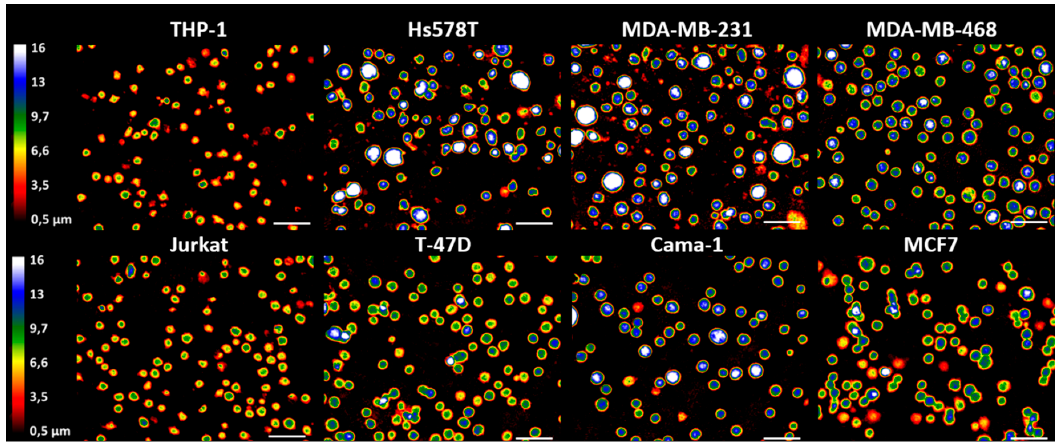
Figure 2. DHC holographic phase image in 2D. Two white blood cell lines (THP-1 and Jurkat) and six different breast cancer cell lines were analyzed with DHC. The color scale bars represent the thickness of the cells in µm, and the scale bars represent 10 µm.